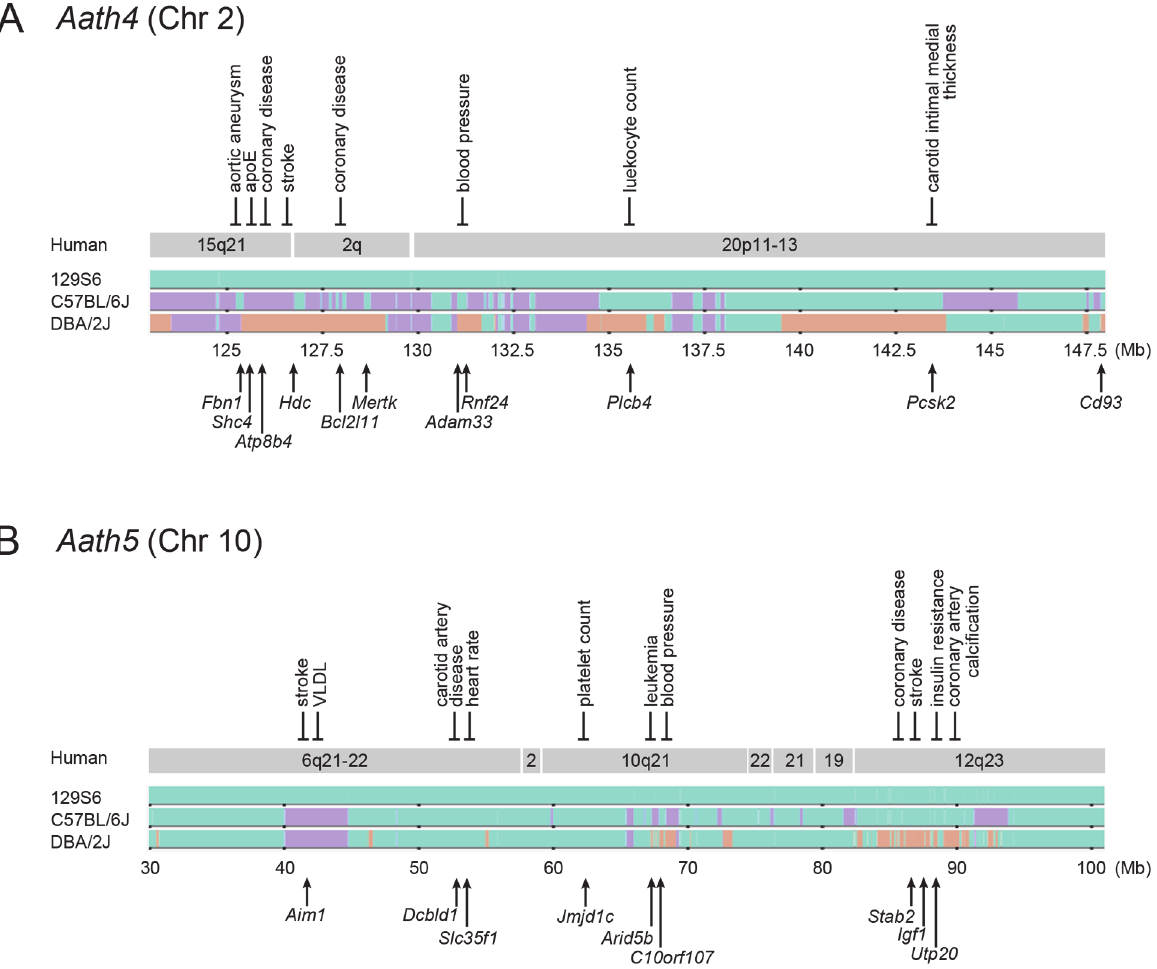
Fig 4. Haplotype comparison. Chromosome maps of Aath4 on Chr 2 (A) and Aath5 on Chr 10 (B) from UNC Mouse Phylogeny Viewer. 129 sequences and B6/DBA regions identical to 129 are shown in green; B6 sequences different from 129, and DBA sequences identical to B6 but not to 129 are shown in purple; DBA-specific sequences are shown in orange. Arrows below indicate the position of representative candidate genes. Homologous human chromosomal regions are derived from the Virtual Comparative Map (VCMap) tool. Human disease-associated regions are indicated above the human chromosomal